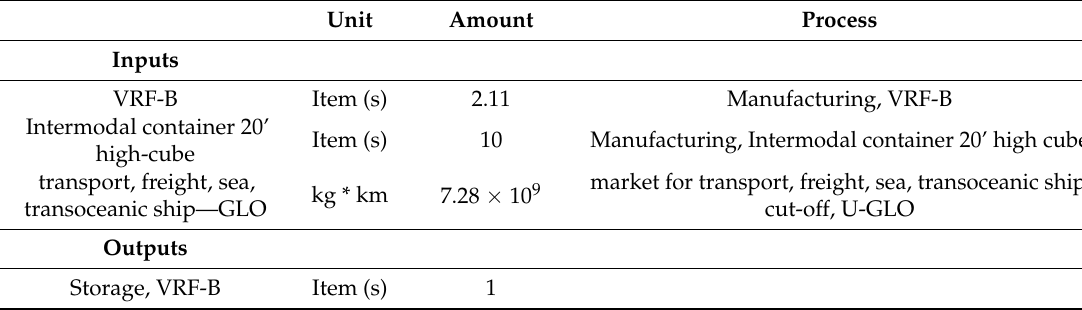
Table A22. Manufacturing Storage, VRF-B.